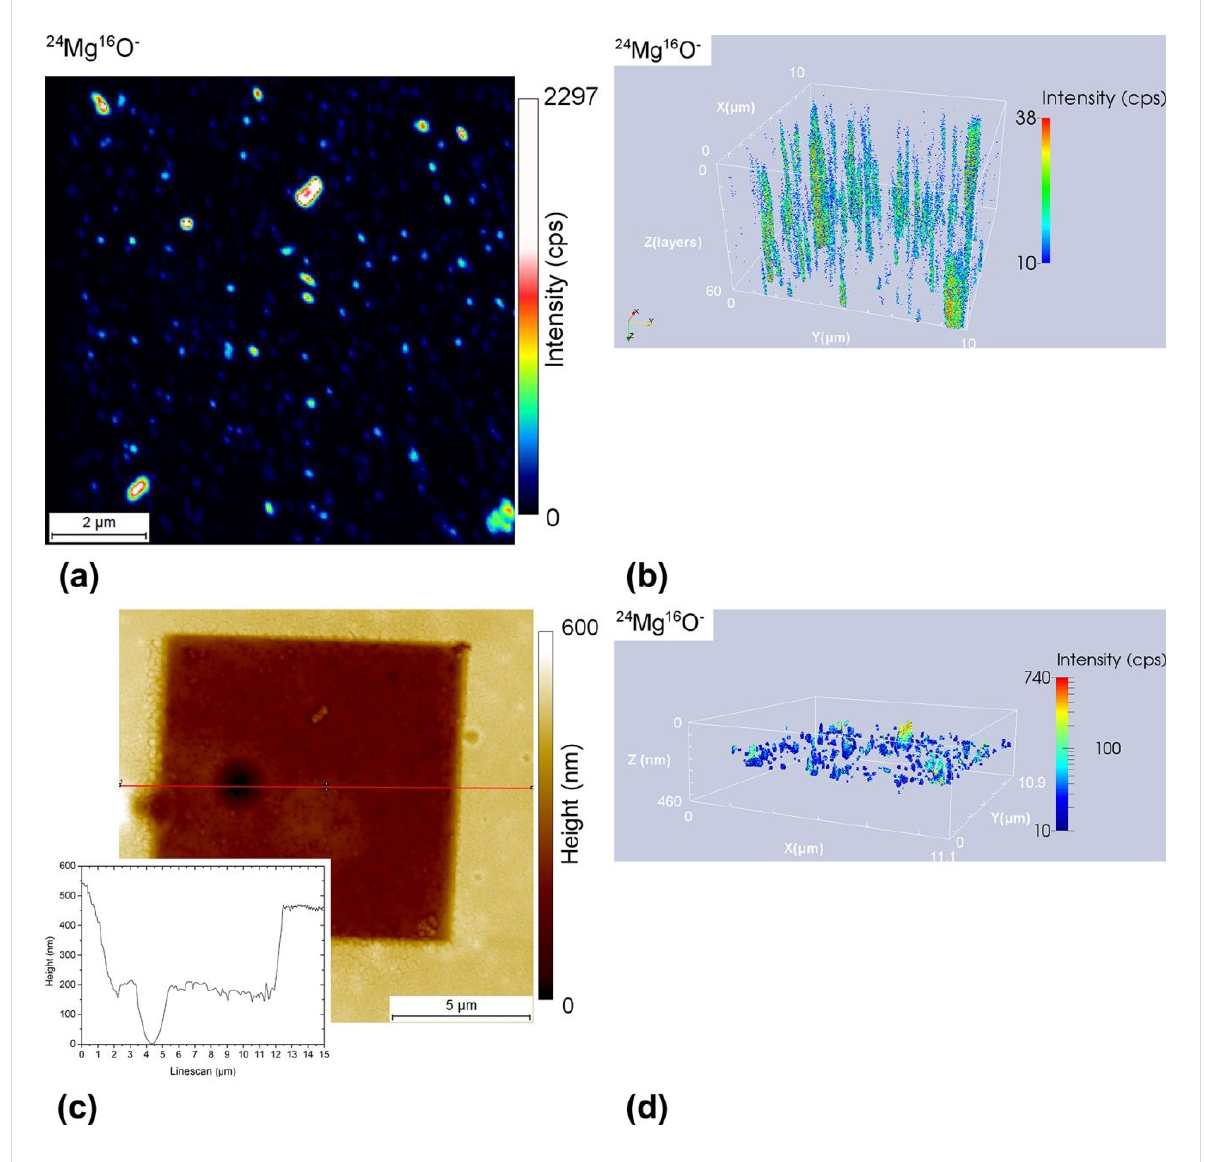
Figure 5: 2D mapping of 24 Mg 16 O − secondary ion signal summed over analysis depth (a). 3D volume reconstruction using the traditional method assuming a flat sample surface and a homogenous sample sputtering (b) Sample topography after SIMS sputtering including inset linescan plot illus- trating the depth profile through the middle of the SIMS analysed area (c) 3D volume reconstruction making use of the combined information from SIMS and AFM (d). Panels b and d are shown at the same aspect